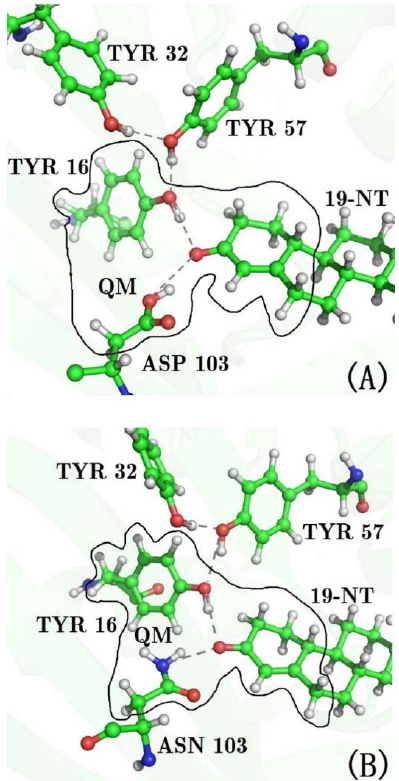
Figure 2. Structures of the hydrogen bonding network of the active site of KSI. ( A ) wild type ( B ) D103N mutant. The side chains of residues 16, 103, and the ring of 19-NT, which the C=O group bonds to, were partitioned into the QM region in the QM/MM MD simulations.